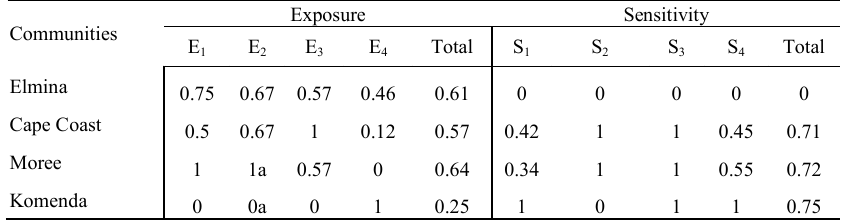
Table 3: Scores of exposure and sensitivity for the four